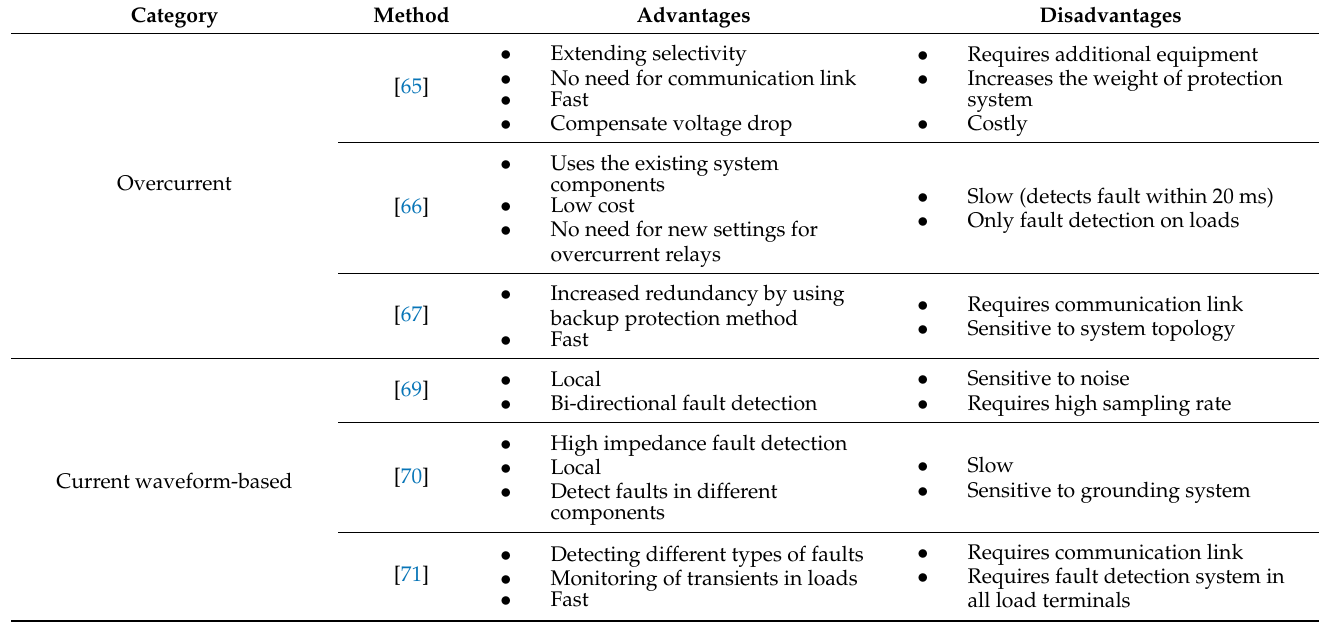
Table 3. Summary of fault detection